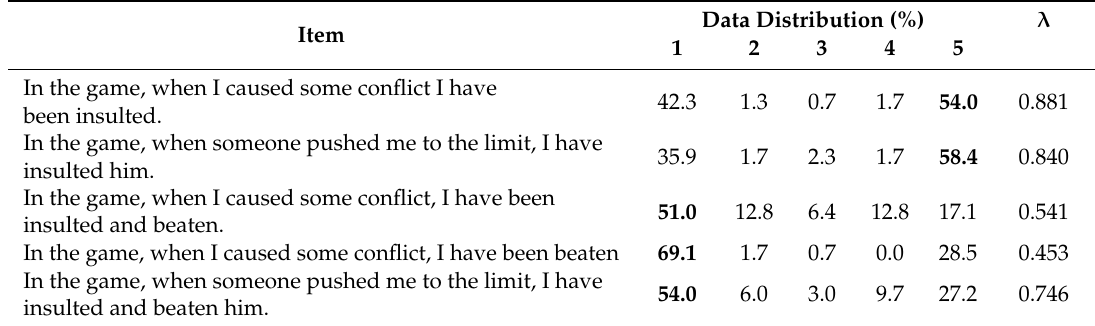
Table 4. Data distribution and factor loadings of CONFLICT1-RES (Version 3) for Sample B.